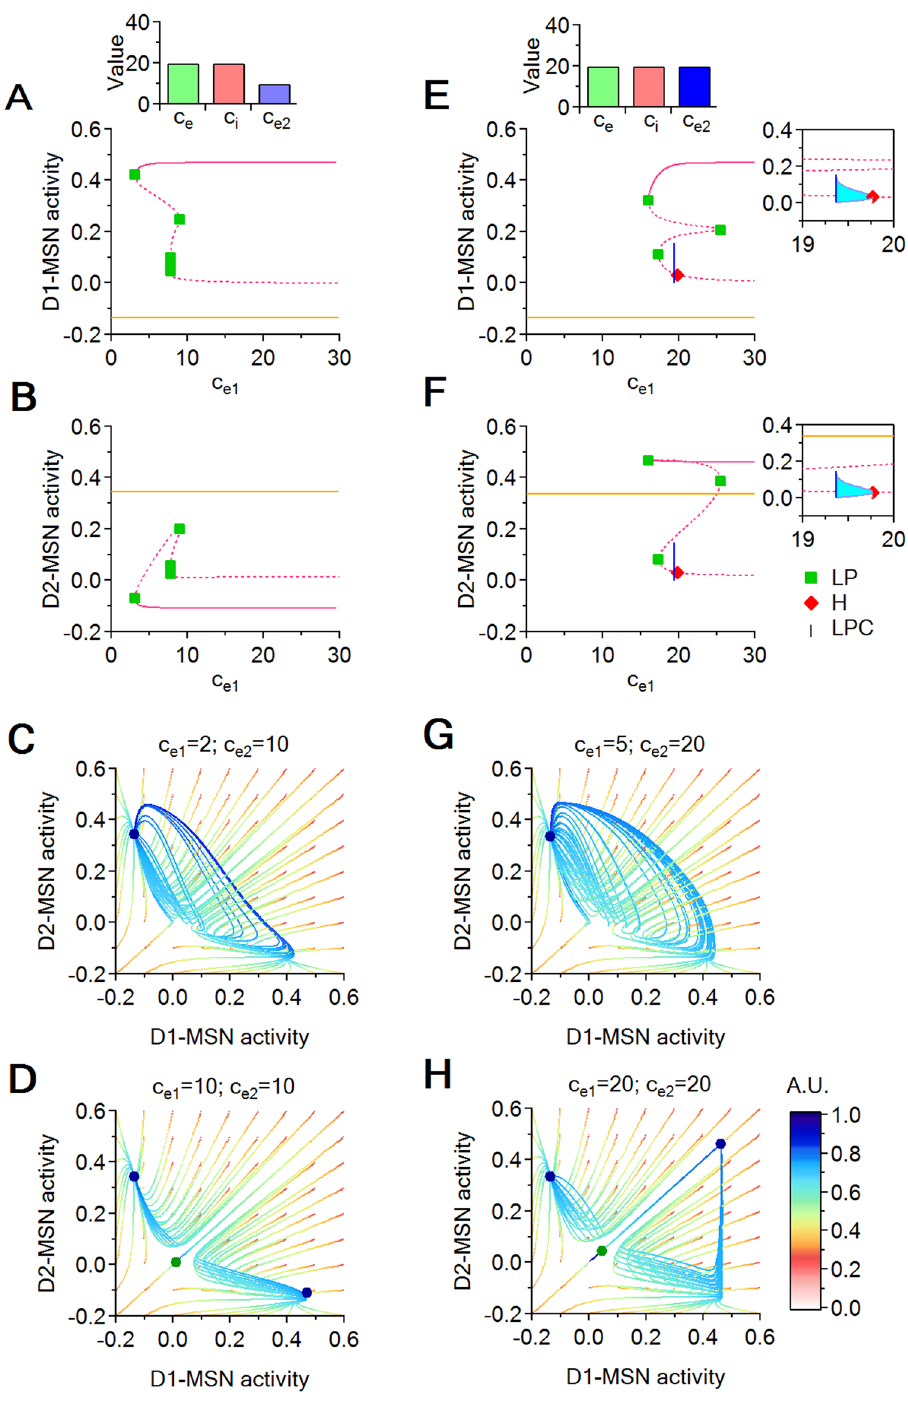
Figure 5. Bifurcation diagrams with respect to c for increasing values of c , and corresponding phase plane e 1 e 2 ( D 1, D 2) slices. ( A , B ) Bifurcation diagrams showing D1- ( A ) and D2-MSNs ( B ) coordinate projections for increasing values of c , when = c 10 . Each panel shows the position of stable (solid line) and unstable e 2 e 1 equilibrium curves (dotted lines). The diagrams include LPs (green squares), supercritical H bifurcation points (red diamonds) and LPCs (blue vertical line). ( C , D ) Phase plane dynamics for = c 10 . The panels show phase e 2 plane slices, in which each curve represents the projection of a seven dimensional trajectory to the ( D 1, D 2) plane. Each phase plane plot uses a grid of initial conditions of resolution 0.1 within the ( D 1, D 2) plane. All temporal trajectories evolve from red to cyan. Stable equilibria are shown as blue circles and saddle points are shown as green circles. ( E , F ) As in ( A , B ), for = c 20 . The insets show saddle cycles born at supercritical H e 2 bifurcations (cyan). The cycles stop at the blue vertical line representing an LPC bifurcation, at which the cycle branch born from the H point collides with another cycle branch (not shown) and disappears. ( G , H ) Phase plane dynamics for = c 20 e 2